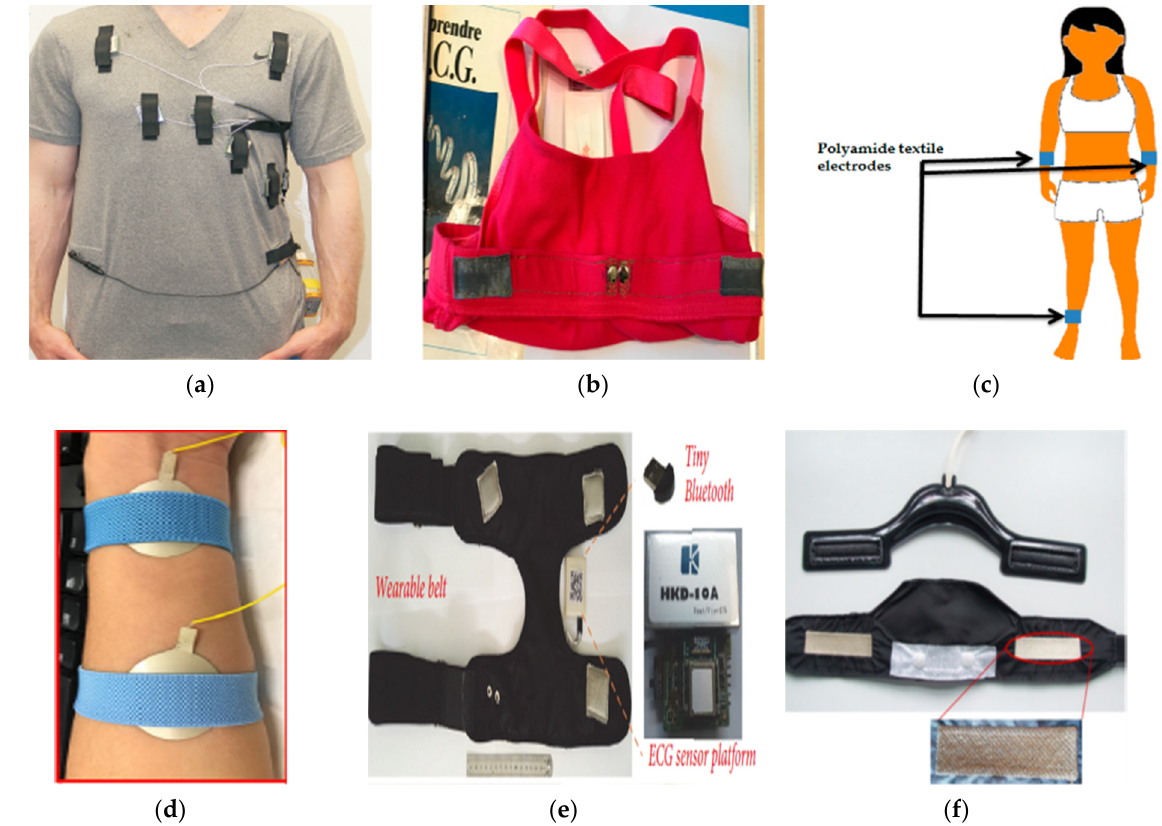
Figure 9. Different wearable textile ECG monitoring systems: ( a ) ECG T-shirt with active electrodes and connectors, adapted from [74]; ( b ) PEDOT:PSS-coated polyamide electrodes sewn into bras, adopted from [24]; ( c ) electrode placement for ECG measurement where plastic clamps were used to fix the electrodes onto the wrist, adopted from [92]; ( d ) ECG sensing wristband with printed and flexible electrodes, adapted from [91]; ( e ) wearable chest belt with silver-coated nylon woven electrodes and Bluetooth module, adopted from [123]; ( f ) ECG belt with wetting pad (above) and the embroidered electrodes (below), adopted from [103].